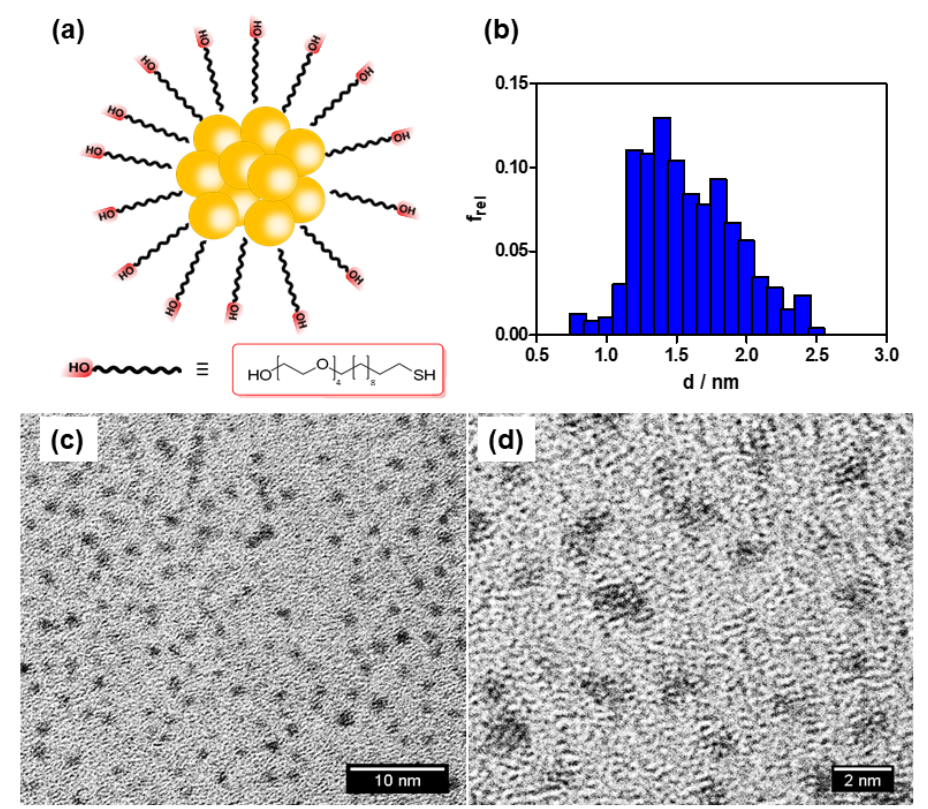
Figure 1. Characterization of gold nanoclusters. ( a ) Schematic representation of the structure of AuNCs; ( b ) Particle size distribution; ( c ) TEM micrography at 120,000×; ( d ) TEM micrography at 500,000×.